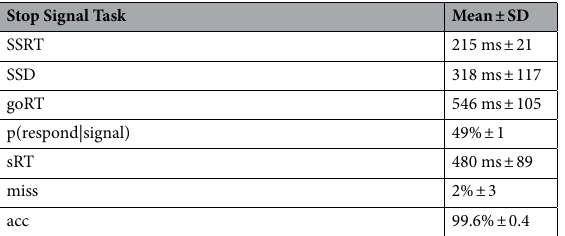
Table 1. Descriptive statistics of the Stop Signal Task. Values in the table represent means and standard deviations of the descriptive statistics of the Stop Signal Task. Legend: SSRT = Stop Signal Reaction Time; SSD = Stop Signal Delay; goRT = RT on go trials; p(respond|signal) = probability of responding on a stop trial; sRT = RT of go responses on unsuccessful stop trials; miss = probability of go omissions; acc = accuracy rate on go trials.